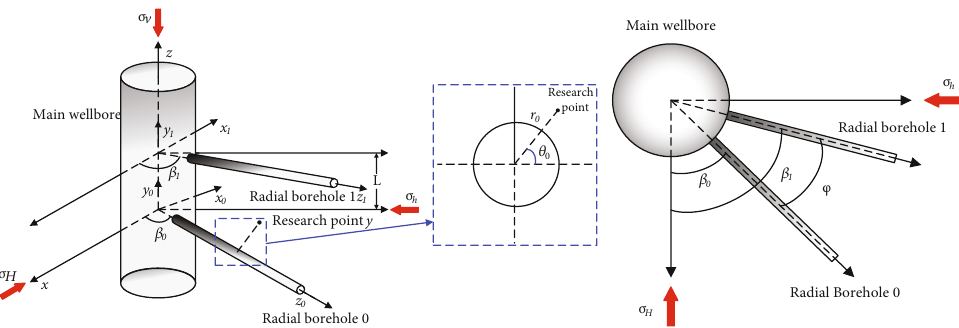
Figure 2: Schematic diagram of hydraulic fracturing guided by multi-radial